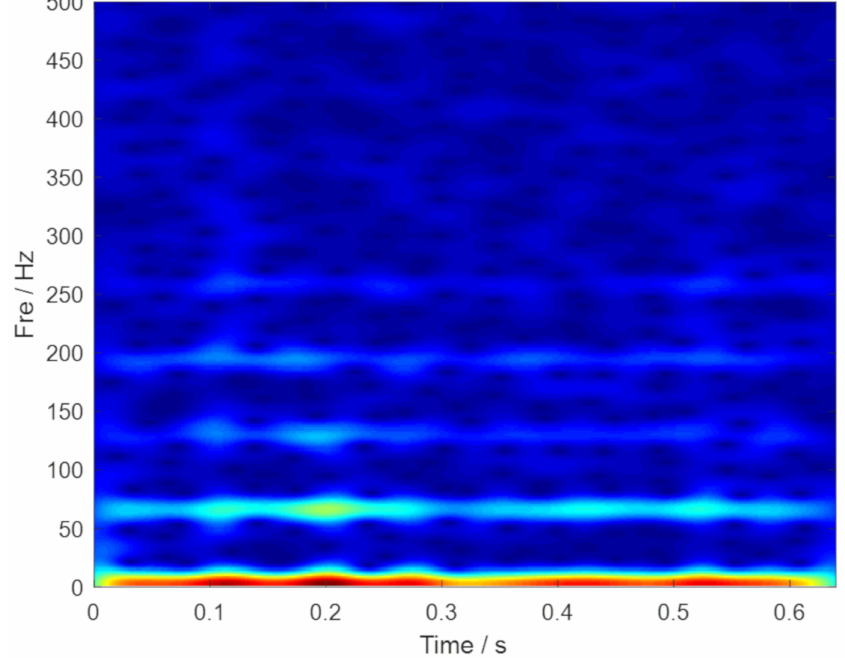
Figure 15. The result of the envelope spectrum analysis to the fan vibration signal. ( a ) Envelope signal shown in time-domain; ( b ) Envelope signal shown in frequency-domain.